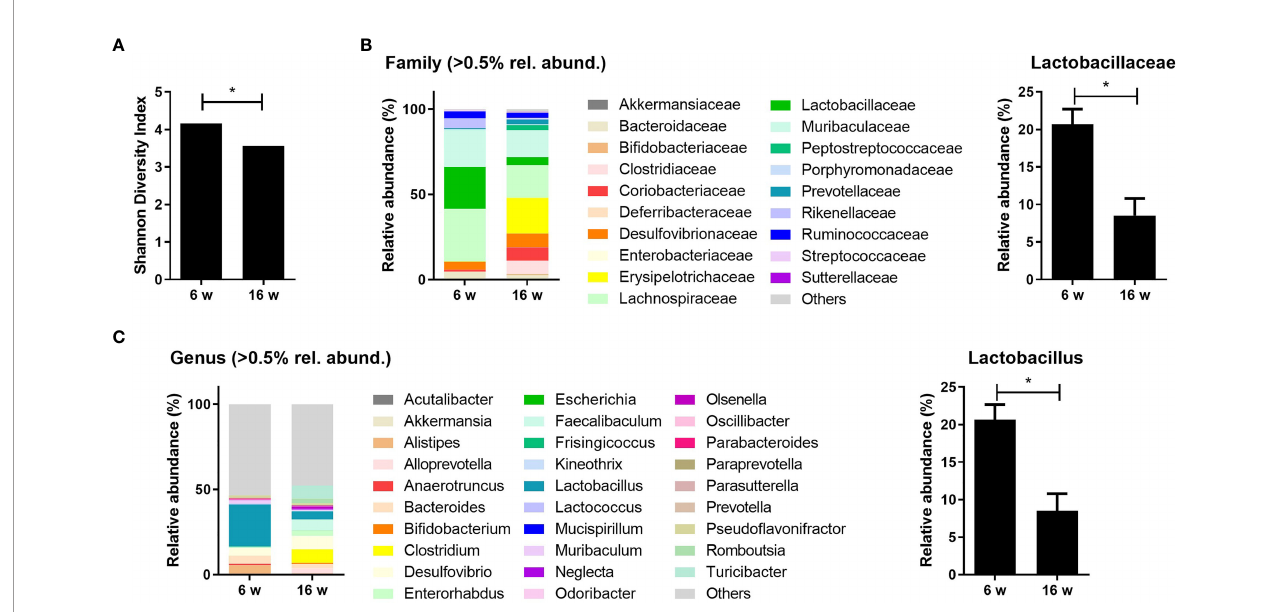
FIGURE 1 | Lupus-prone mice exhibit gut dysbiosis with a reduction in Lactobacillus species. (A) Shannon diversity indices of the cecal microbiota from MRL/ lpr mice at 6 and 16 weeks old ( n = 4). (B, C) The relative abundance of cecal microbiota at the family and genus levels in MRL/ lpr mice ( n = 3) at 6 and 16 weeks old. The relative abundance of Lactobacillaceae (B) and Lactobacillus (C) . All experiments were performed at least three times in triplicate. Data are shown as mean ± SEM. * p <